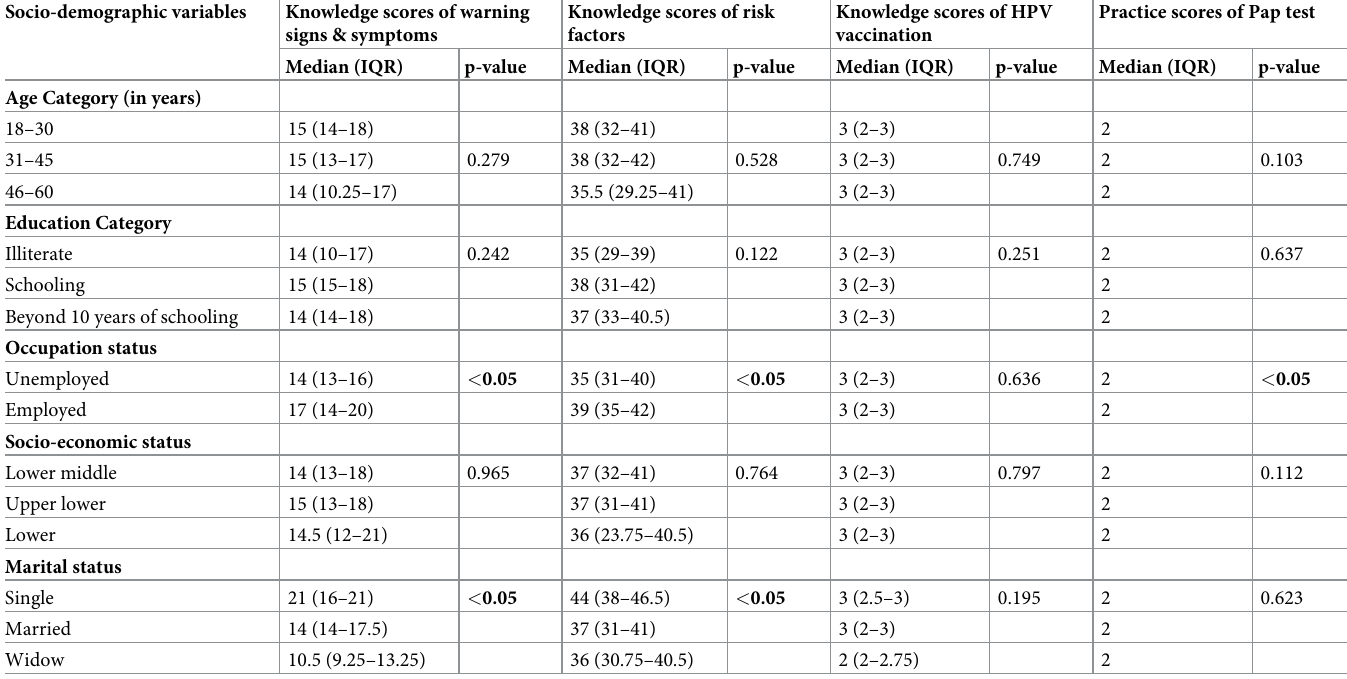
Table 5. Comparison between median knowledge scores of warning signs and symptoms, risk factors of cervical cancer and HPV vaccination and median practice scores of Pap test across socio-demographic variables after mHealth intervention (n =